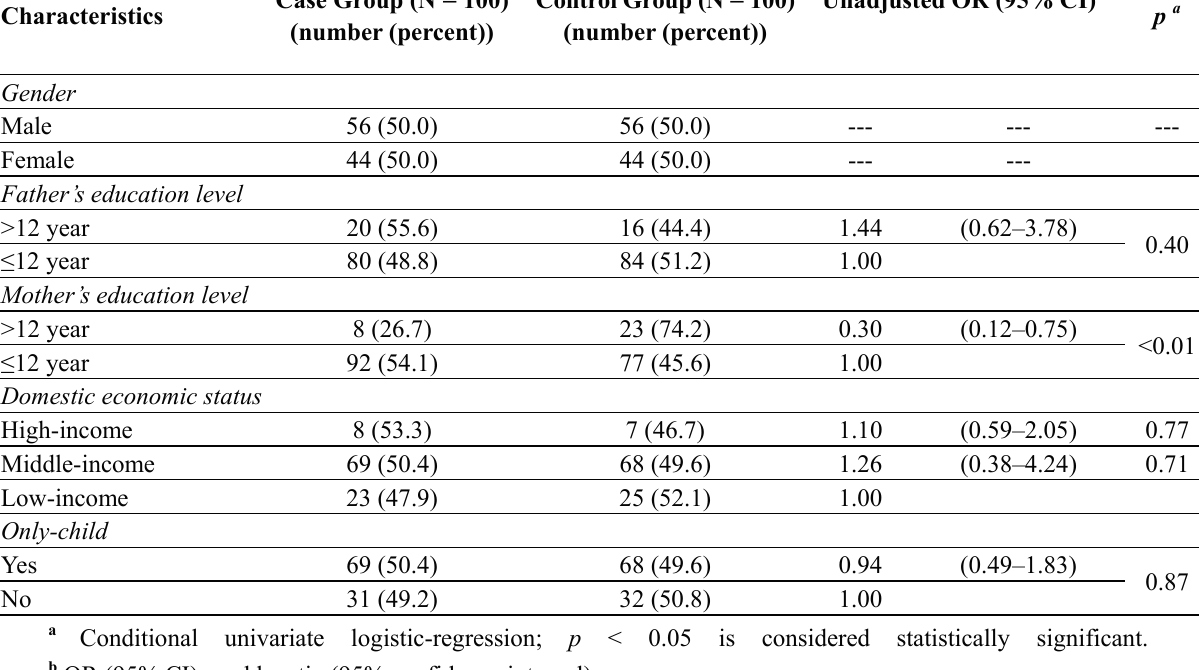
Table 1. Odds ratio for conditional logistic regression between social-demographic characteristics and caries experience in children with CHD.